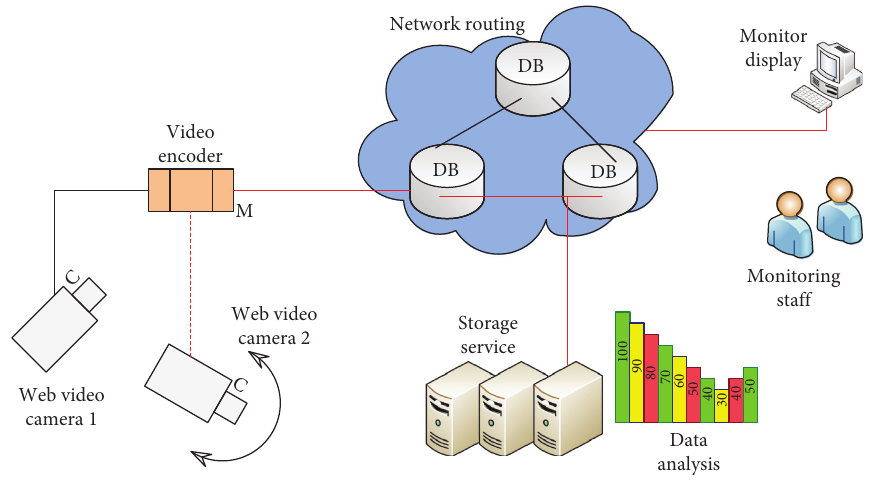
Figure 3: The system hardware structure.